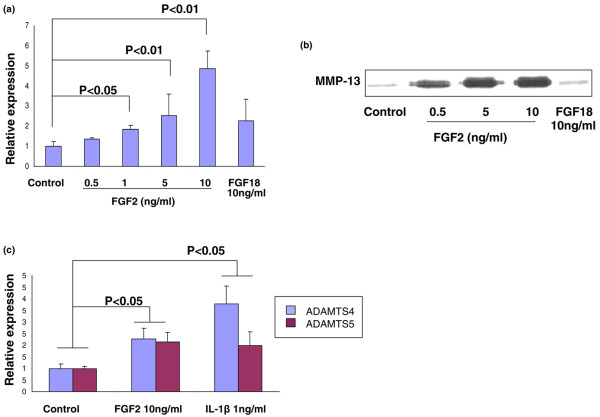
Fibroblast growth factor 2 increases the expression of cartilage-degrading enzymes by bovine intervertebral disc cells. Nucleus pulposus cells isolated from bovine intervertebral disc were cultured in monolayer in 12-well plates at 8 × 105 cells/cm2, and were serum-starved by changing the media to serum-free DMEM/F-12 with antibiotics for 24 hours before treatment. Cells were then treated with 0.1 to 10 ng/ml fibroblast growth factor 2 (FGF2) and 100 ng/ml fibroblast growth factor 18 (FGF18), collected after 24 hours, and the total RNA extracted to perform real-time RT-PCR for (a) MMP-13 gene expression and (c) ADAMTS4 and ADAMTS5 gene expression. (b) Conditioned media was subjected to immunoblotting for the product of pro MMP-13. Error bars represent three different donors in three separate experiments.